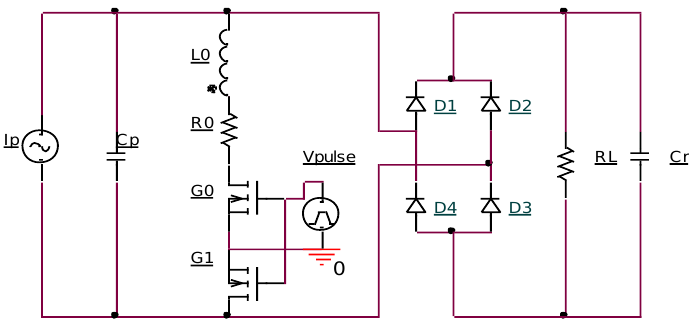
Figure 7. P-SSHI circuit built in PSPICE.